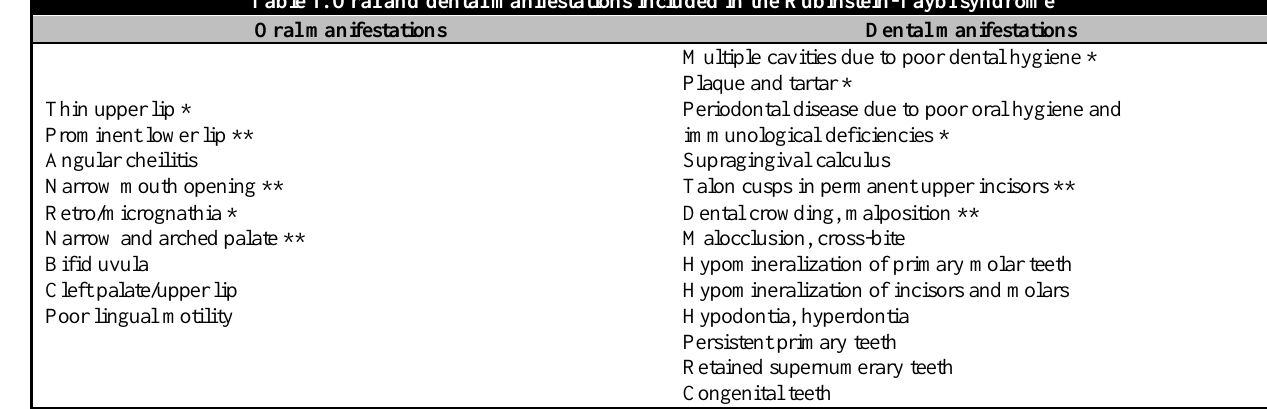
Table 1. Oral and dental manifestations included in the Rubinstein-Taybi syndrome